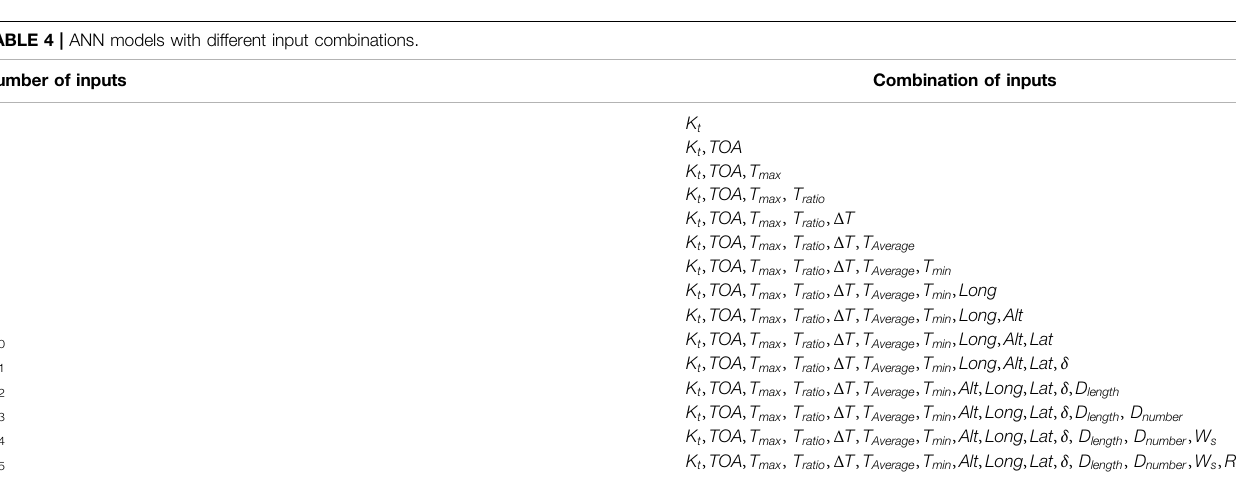
TABLE 4 | ANN models with different input